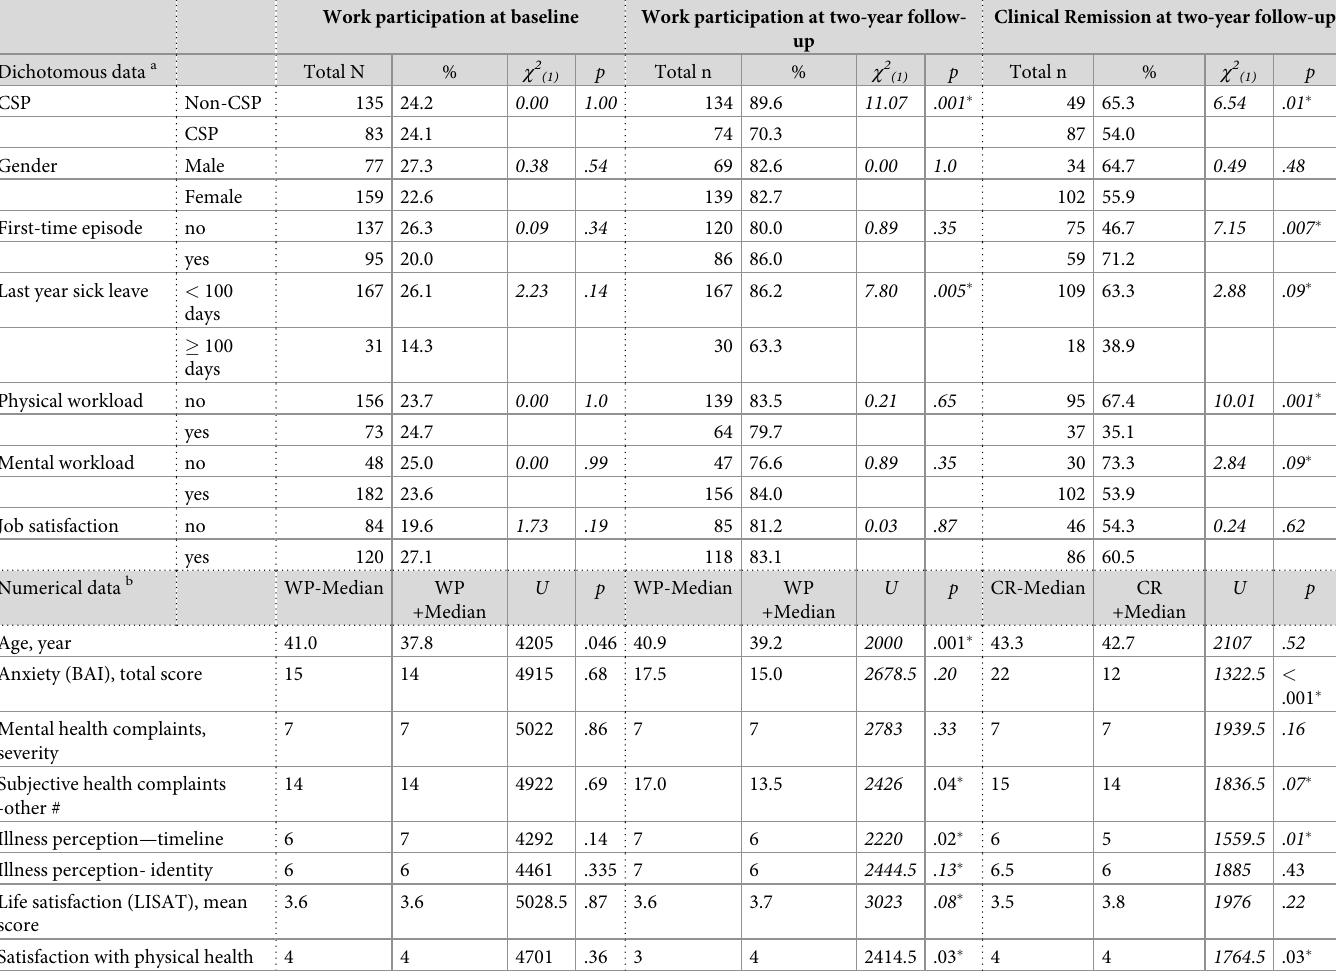
Table 4. Association of the selected variables with treatment response (WP2yr and CR2yr) and baseline WP. Work participation at